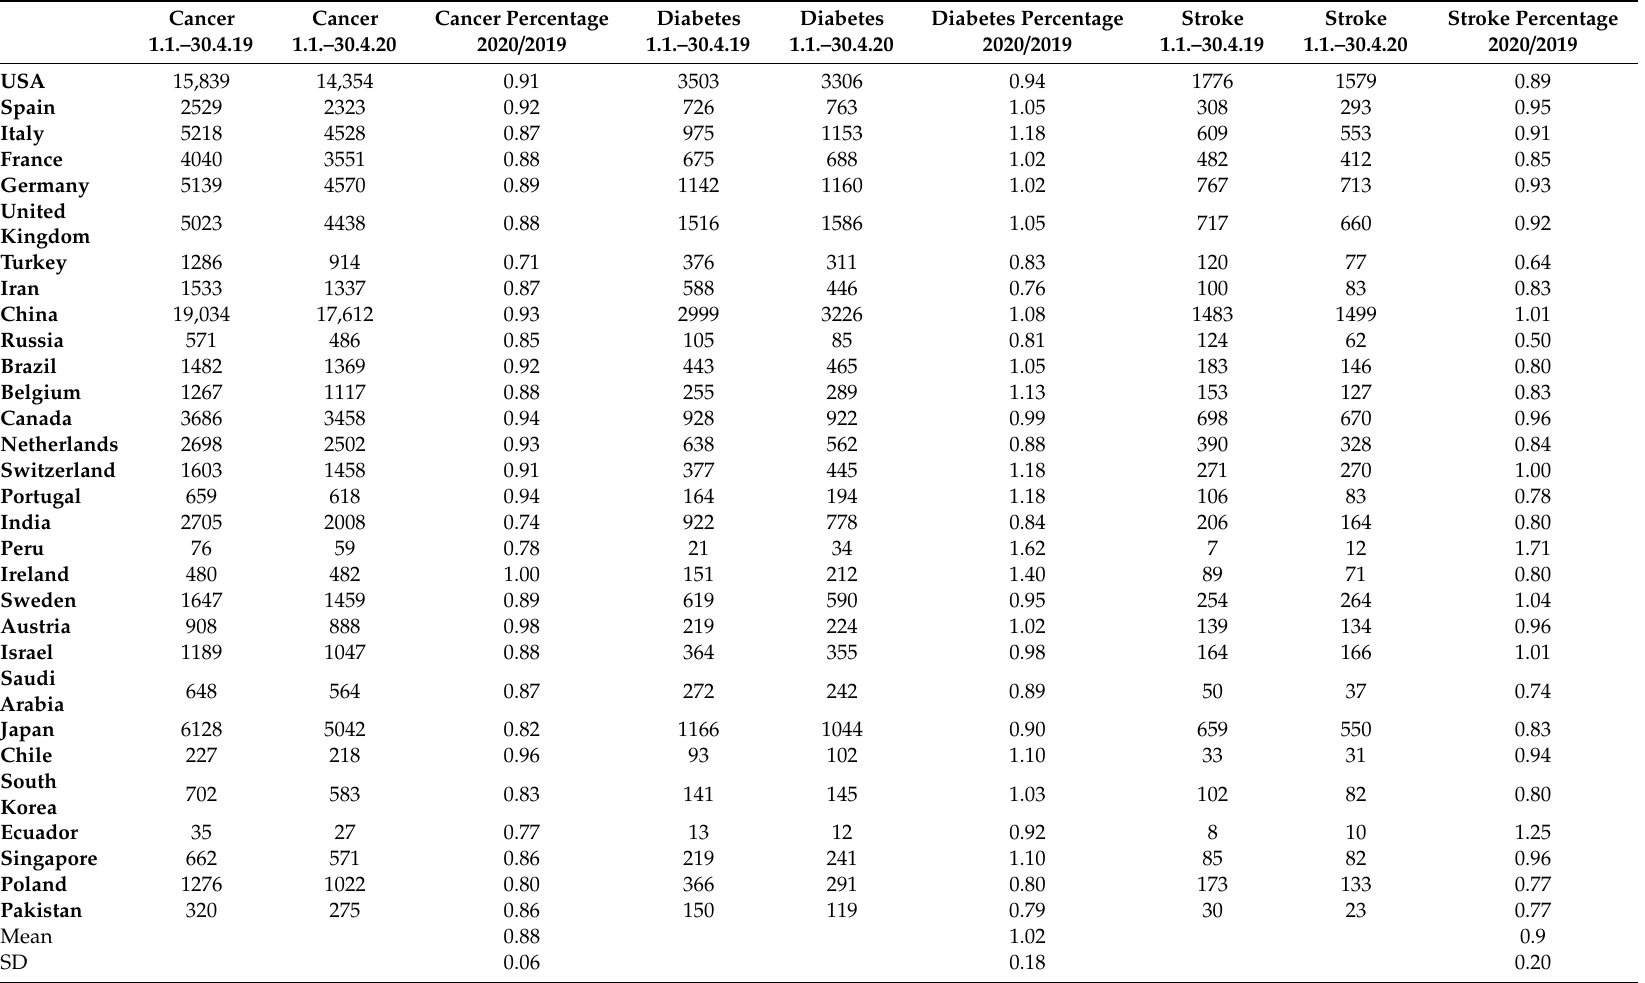
Table A2. The absolute numbers and percentage of the 2020 / 2019 ratio of the COVID-19- and the non-COVID-19-publication rates for Cancer, Diabetes and Stroke between January 1 and April 30 2020 and the pre-year